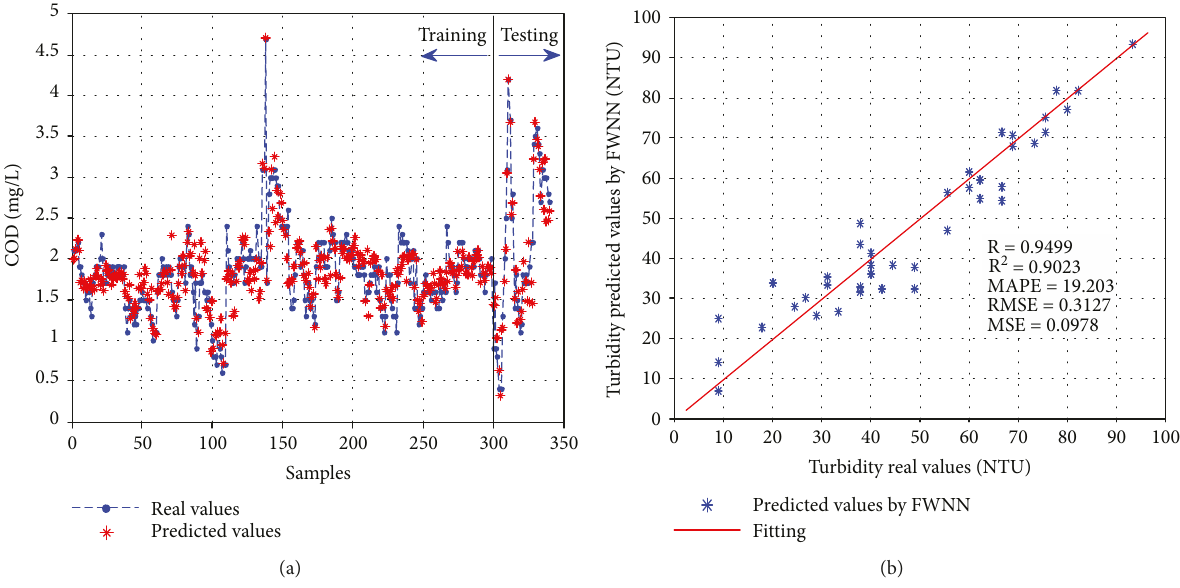
Figure 5: FWNN performance of the estimation of water quality for COD.